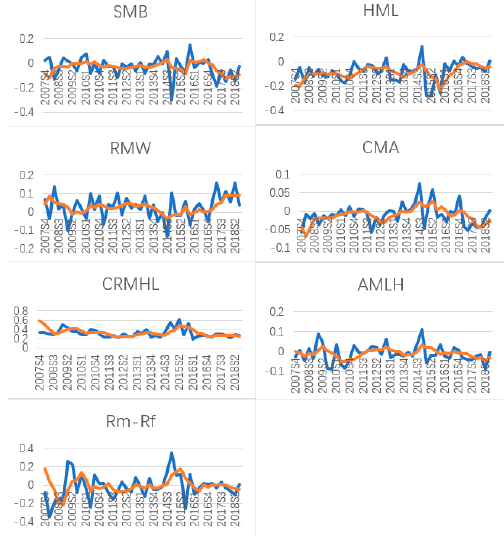
Figure 8. Four seasons moving average of seven factors.